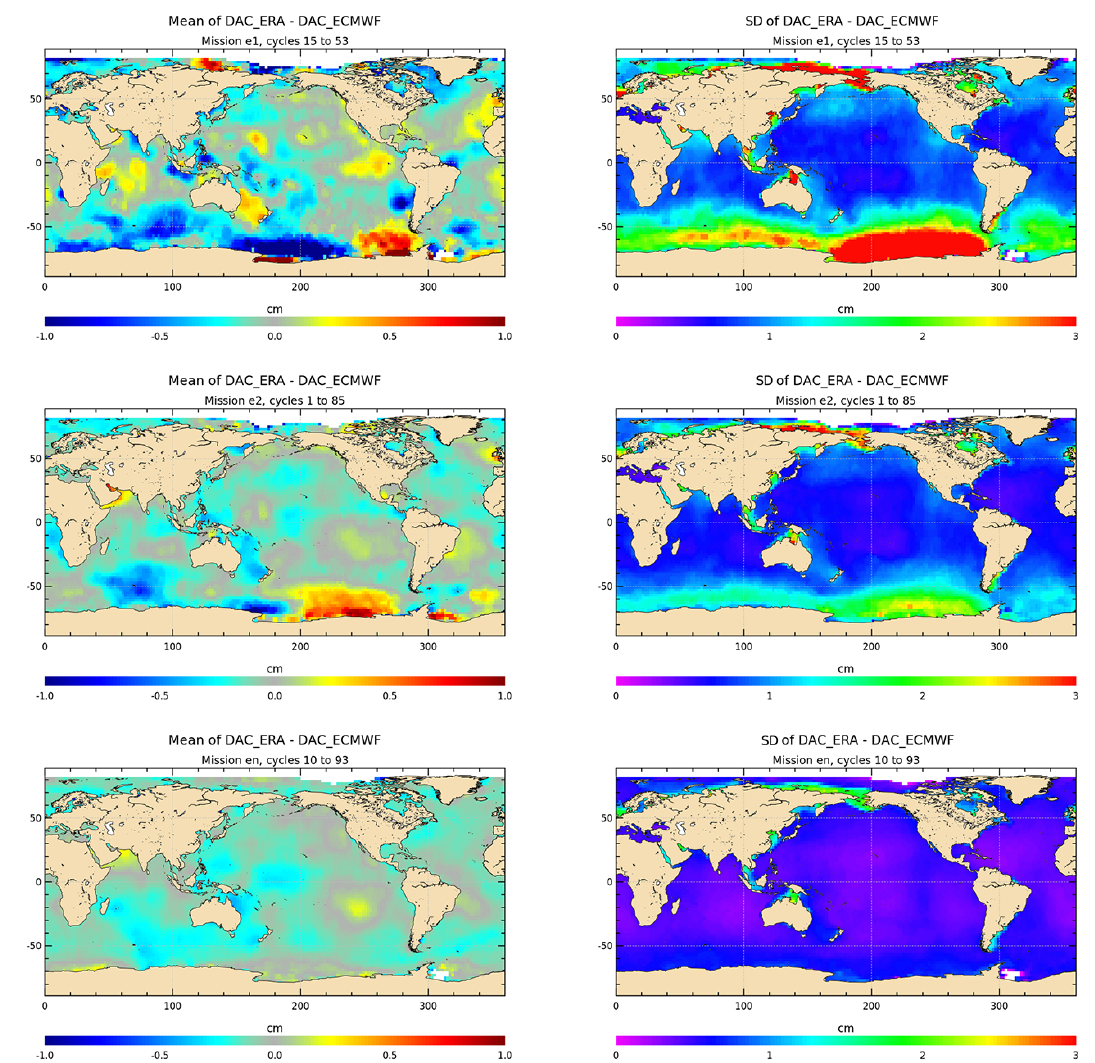
Figure 4. Statistics of differences between DAC_ERA and the operational DAC seen by ERS-1, ERS-2, and Envisat altimeter missions (mean and standard deviation in